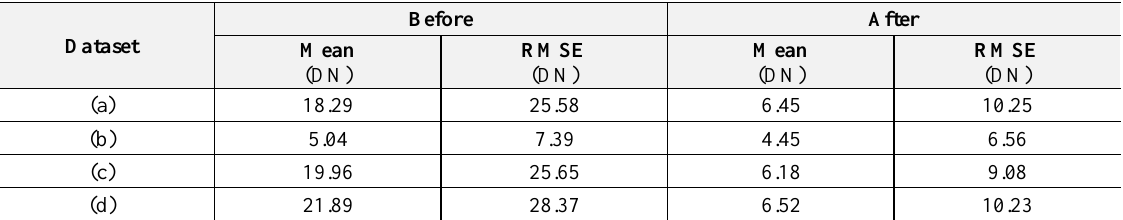
Table 3. characteristics of